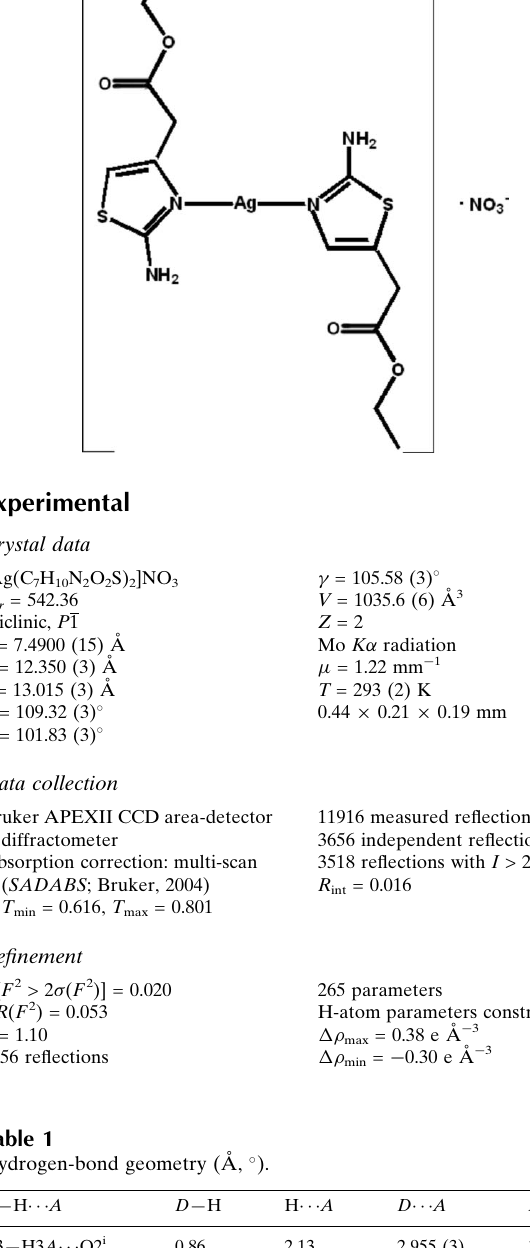
Hydrogen-bond geometry (A˚ , (cid:1)